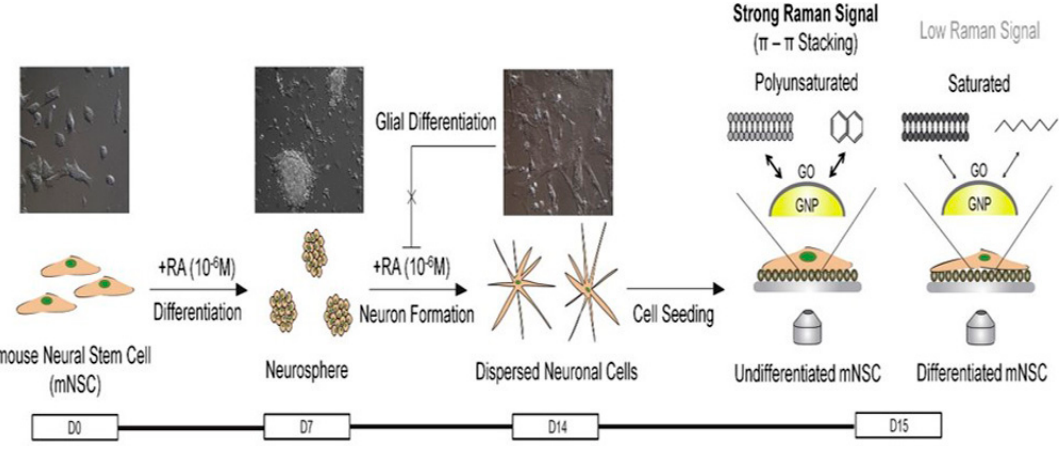
Figure 14. Schematic diagram representing the method to detect the undifferentiated and differentiated state of mNSCs using 3D GO-encapsulated AuNPs. Adapted from [139], with permission from ©2013 Elsevier.